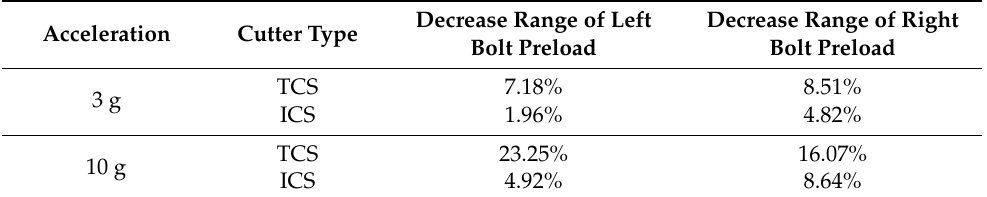
Table 5. Decrease ranges of the bolt preloads of the ICSs and the